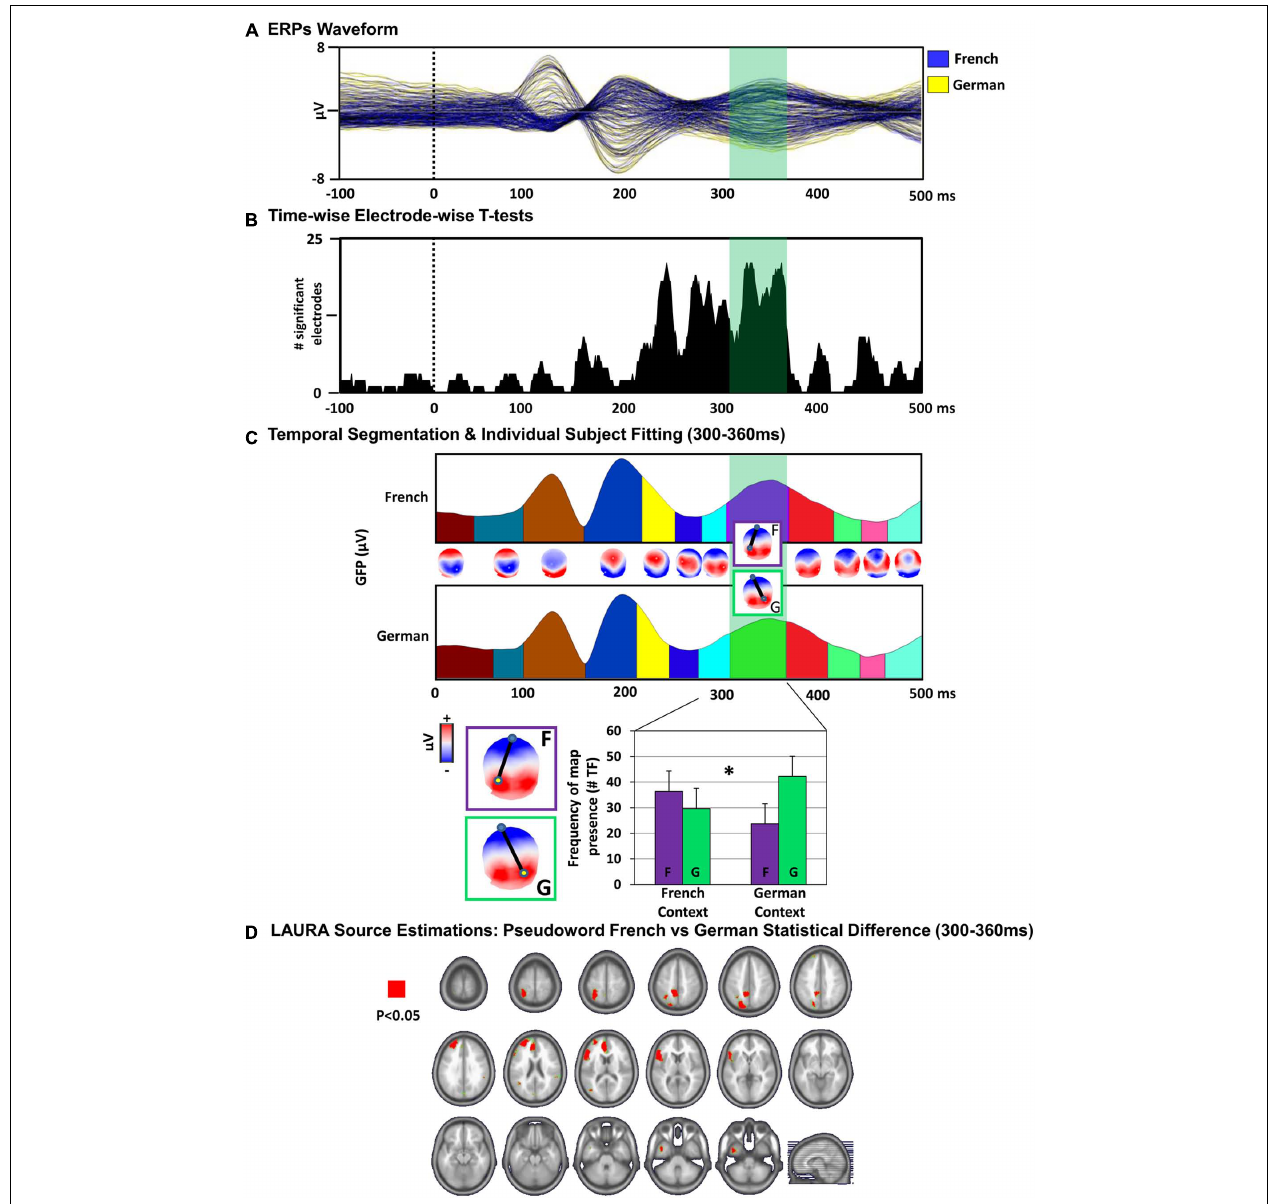
FIGURE 3 | Electrical neuroimaging results. (A) ERPs waveform. The group-averaged ERPs to PW reading in the French (blue) and German (yellow) language context are displayed in microvolts as a function of time relative to stimulus onset (dotted black line). The time period showing significant ( p < 0.05) topographic differences between the conditions is indicated in green. (B) Time-wise electrode-wise t -tests. Results of the time-wise paired t -tests at each of the 128 scalp electrodes from the group-averaged ERP waveforms are shown ( p < 0.05). (C) Topographic pattern analysis. Top : Topographic pattern analyses identified 12 time periods of stable electric field topography across the collective 500 ms post-stimulus period form the group-averaged ERPs. Topographies (i.e., maps) are shown with the nasion upward and left scalp leftward. The dipole represents the positive and negative maximum of the electric field topography measured at the scalp. Two distinct maps were identified for one of these time periods (300–360 ms) for PWs in the French context (map “F”) versus German context (map “G”) conditions. Bottom: The reliability of this observation at the group-averaged level was assessed at